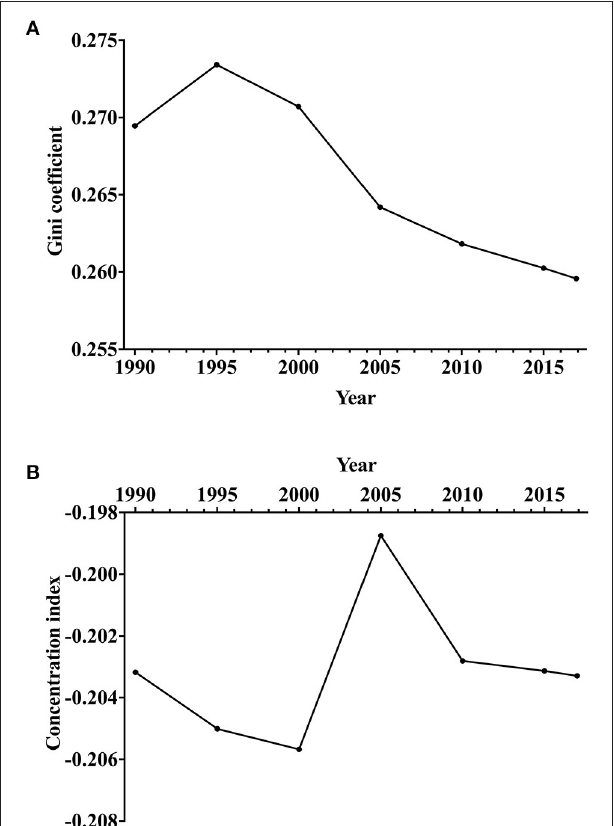
FIGURE 4 | Trends of socioeconomic disparity in epilepsy burden in terms of age-standardized DALY rate across countries from 1990 to 2017. (A) Gini coefficient. (B) Concentration index. DALYs, disability-adjusted